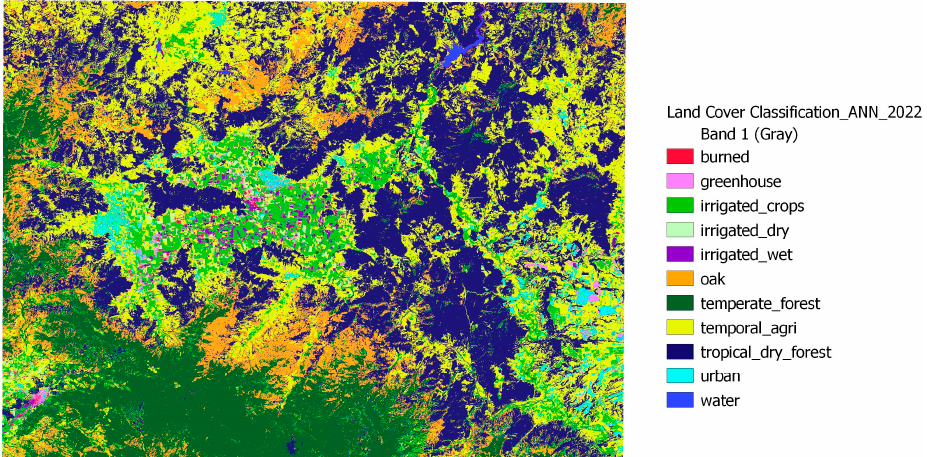
Figure A5. Land cover classification using ANN for 2022. Irrigated crops is short for Irrigated agriculture with crops; Irrigated dry is short for Irrigated agriculture without crops (dry); Irrigated wet is short for Irrigated agriculture without crops (wet); Temporal agriculture is short for Temporal agriculture with pasture; Oak is short for Oak forest.